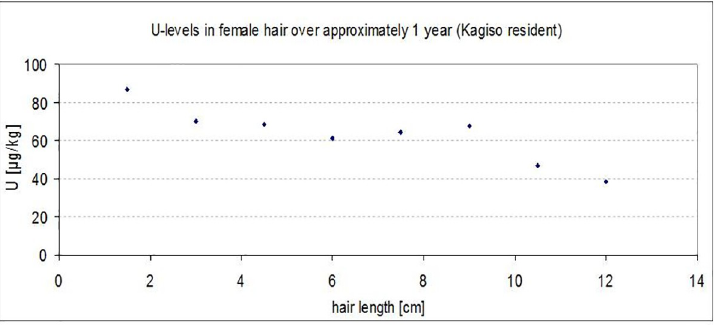
Fig 3. Uranium concentration measured at different lengths of 12 cm long hair from a Black woman from Kagiso.